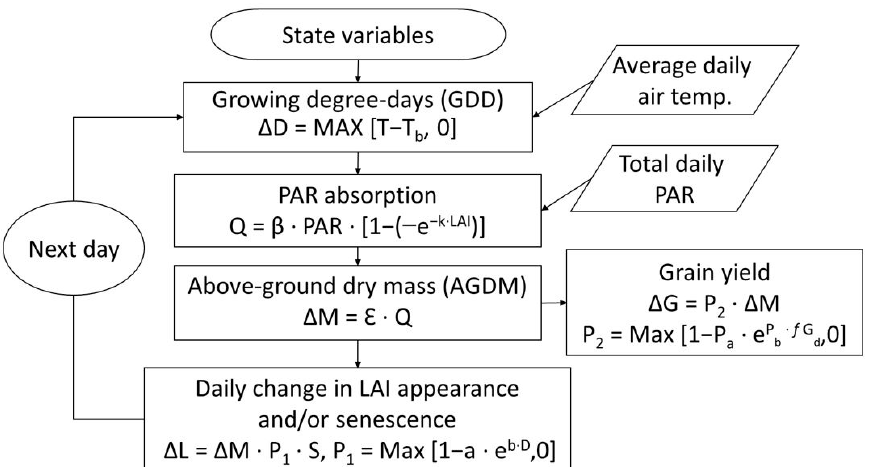
Figure A1. Modelling scheme of daily growth and formulations employed in the remote sensing- incorporated crop model for barley and wheat. ∆ D, diurnal variation in GDD; T, diurnal mean temperature; T b , crop-generic base temperature; Q, photosynthetically active radiation (PAR) absorp- tion; β , the fraction of PAR; k, light extinction coefficient; LAI, leaf area index; ∆ M, diurnal growth in above-ground dry mass; ε , crop-specific light use efficiency; ∆ L, diurnal LAI growth; P 1 , the fraction of ∆ M allocated to leaves; S, specific leaf area; ∆ G, diurnal accumulation in grain; P 2 , the fraction of ∆ M segregated to grains; P 2 , grain-allocating coefficient; P a and P b , coefficients that adjust the extent and form of the function; f G d , the grain-allocating factor based on the accumulated GDD.